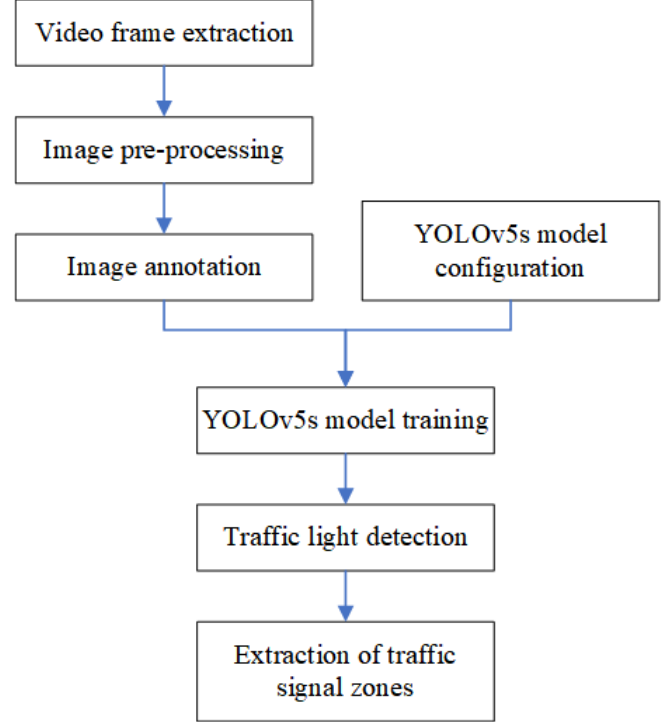
Figure 5. Traffic light detection flow chart.